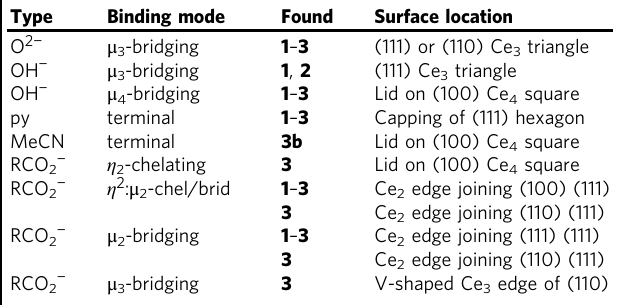
Table 1 Type of surface ligands in nanoclusters 1 –